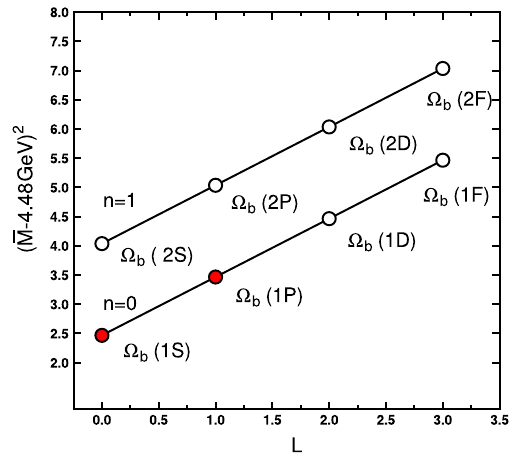
Fig. 2 Regge trajectories of the Ω b baryons relating the shifted spin- averaged mass squared to the orbital angular momentum L of the sys- tems, with the parameters m d = ss = 991 MeV and the Regge slope a = 0 . 318 GeV 2 corresponding to our assignment (13). The (red) solid circles correspond to the observed (mean) masses